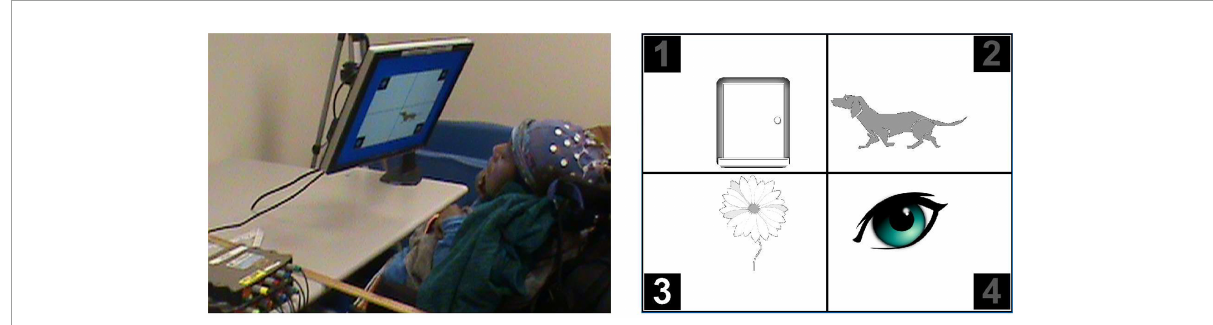
FIGURE1 Left: Participant with cerebral palsy (CP) viewing first calibration screen. Adjustable monitor support enables optimal positioning. Right: Closeup of a later calibration screen, with the stimulus flashing for picture